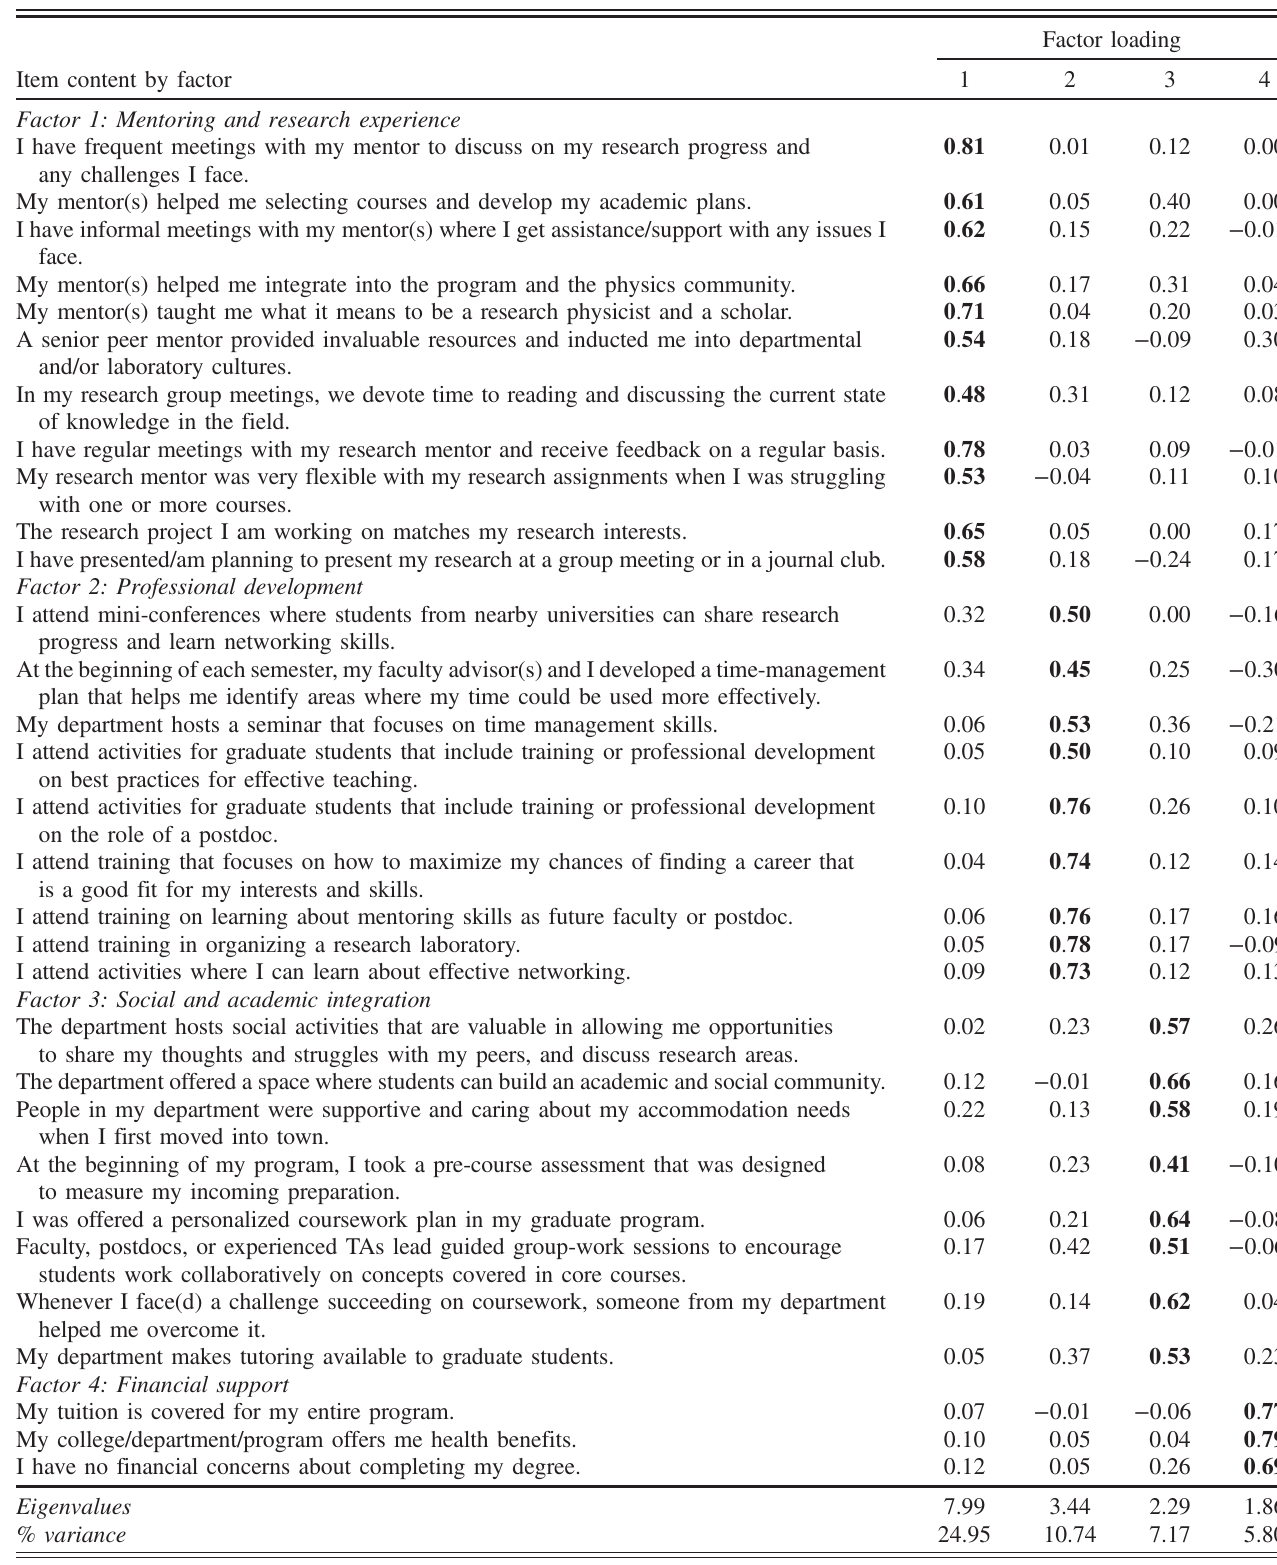
TABLE IV. Loading factors from the rotated four-factor Varimax solution. The bold values indicate the retained factor loadings above 0.40 for each